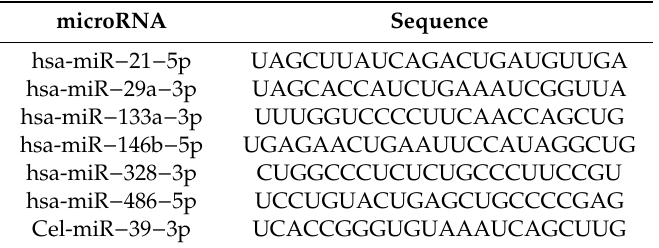
Table 1. MicroRNA primer